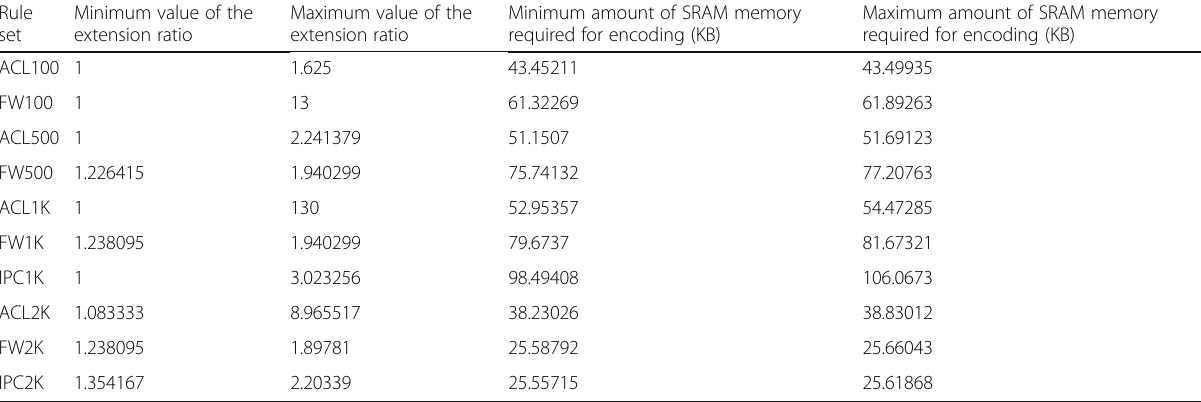
Table 5 The minimum and maximum values of the extension ratio and the memory required for encoding Rule Minimum value of the set extension